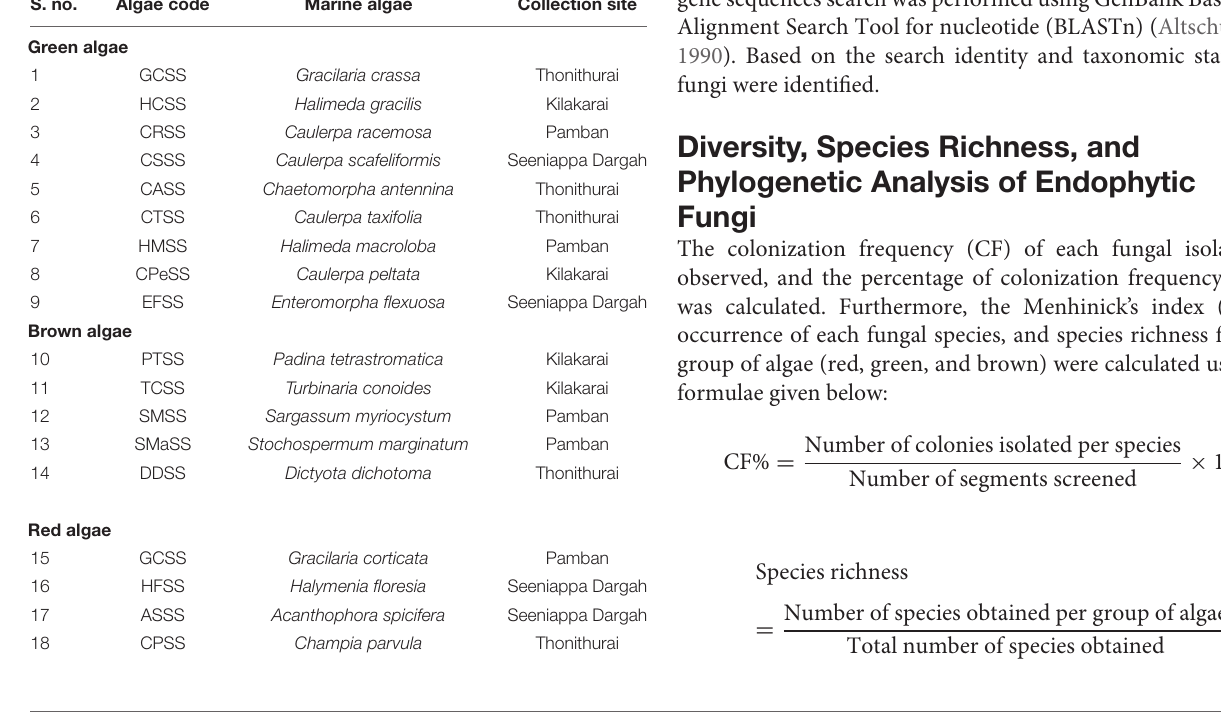
TABLE 1 | List of the collected algae from the Gulf of Mannar, Rameswaram, Tamil Nadu, India. S.